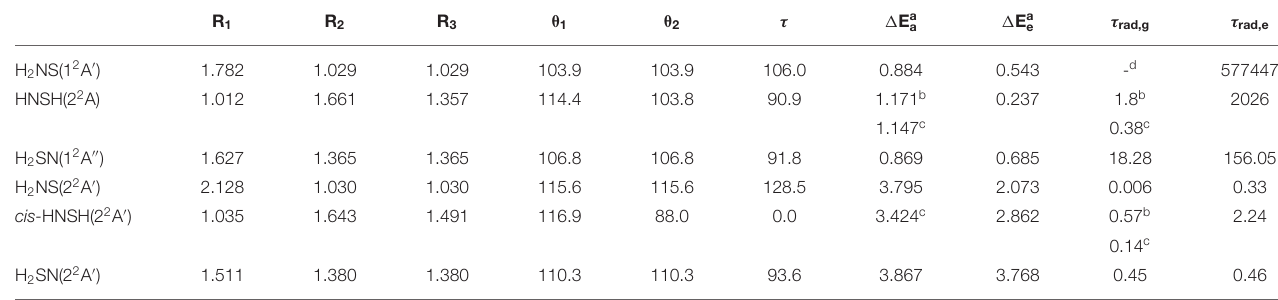
TABLE 3 | CASSCF/CBS optimized equilibrium geometries of [H,H,N,S] isomers in their lowest electronic excited states. R 1 R 2 R 3